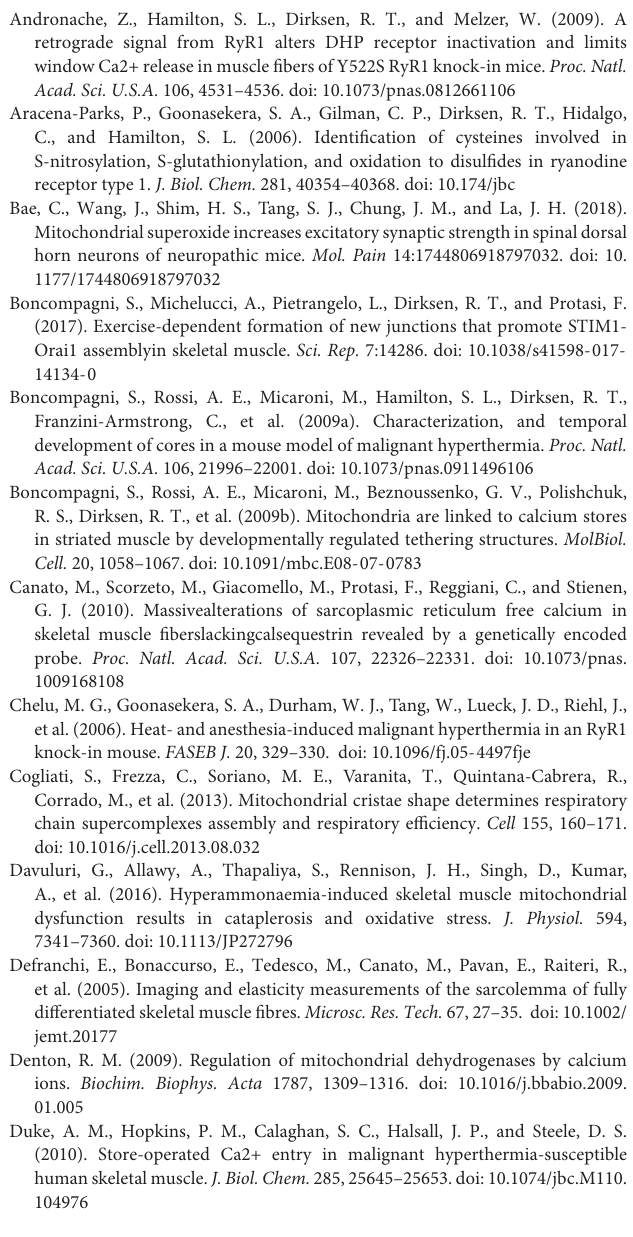
pre-treatment with MitoTempo (MT) for 1 h before the actual experiment. The difference between YS and WT is highly significant, while no difference is detectable between treated and untreated muscle fibers. FIGURE S3 | Model for ROS generation in YS muscle fibers during contractile activity. We propose that the greater response of RyR1 Y524S to caffeine implies not only a greater increase in cytosolic calcium concentration but also a greater calcium uptake by mitochondria. The latter is followed by a significant generation of ROS in the mitochondria, which contributes to RyR nitrosylation together with ROS generation in the cytosol. RyR nitrosylation, in turn, induces a further increase in RyR1 permeability, thus creating a positive feed back loop. Two interventions, reduction of calcium uptake via MCU silencing and control of ROS accumulation with mitotempo, prove to be sufficient to interrupt the positive feed back